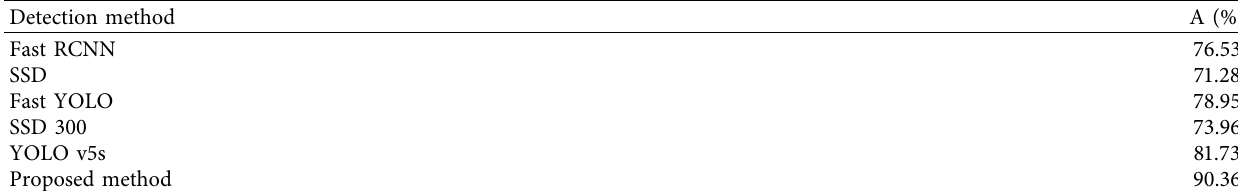
Table 5: Evaluation indices of advanced target detection methods and the proposed method.